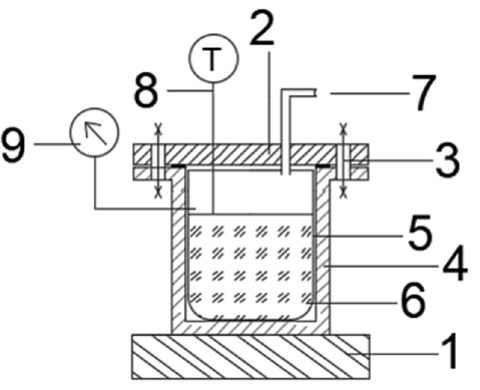
Figure 1. The HTC apparatus: 1 source of heat; 2 autoclave cover; 3 screws; 4 stainless steel auto- clave; 5 glass vessel; 6 spruce bark and deionized water; 7 drain valve; 8 temperature sensor; 9 ma- nometer.